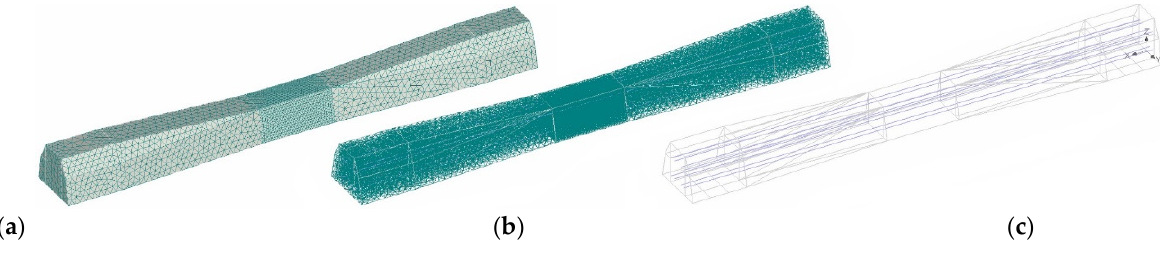
Figure 15. 3D numerical model ( a ); FE mesh ( b ); prestressing reinforcement wires ( c ).